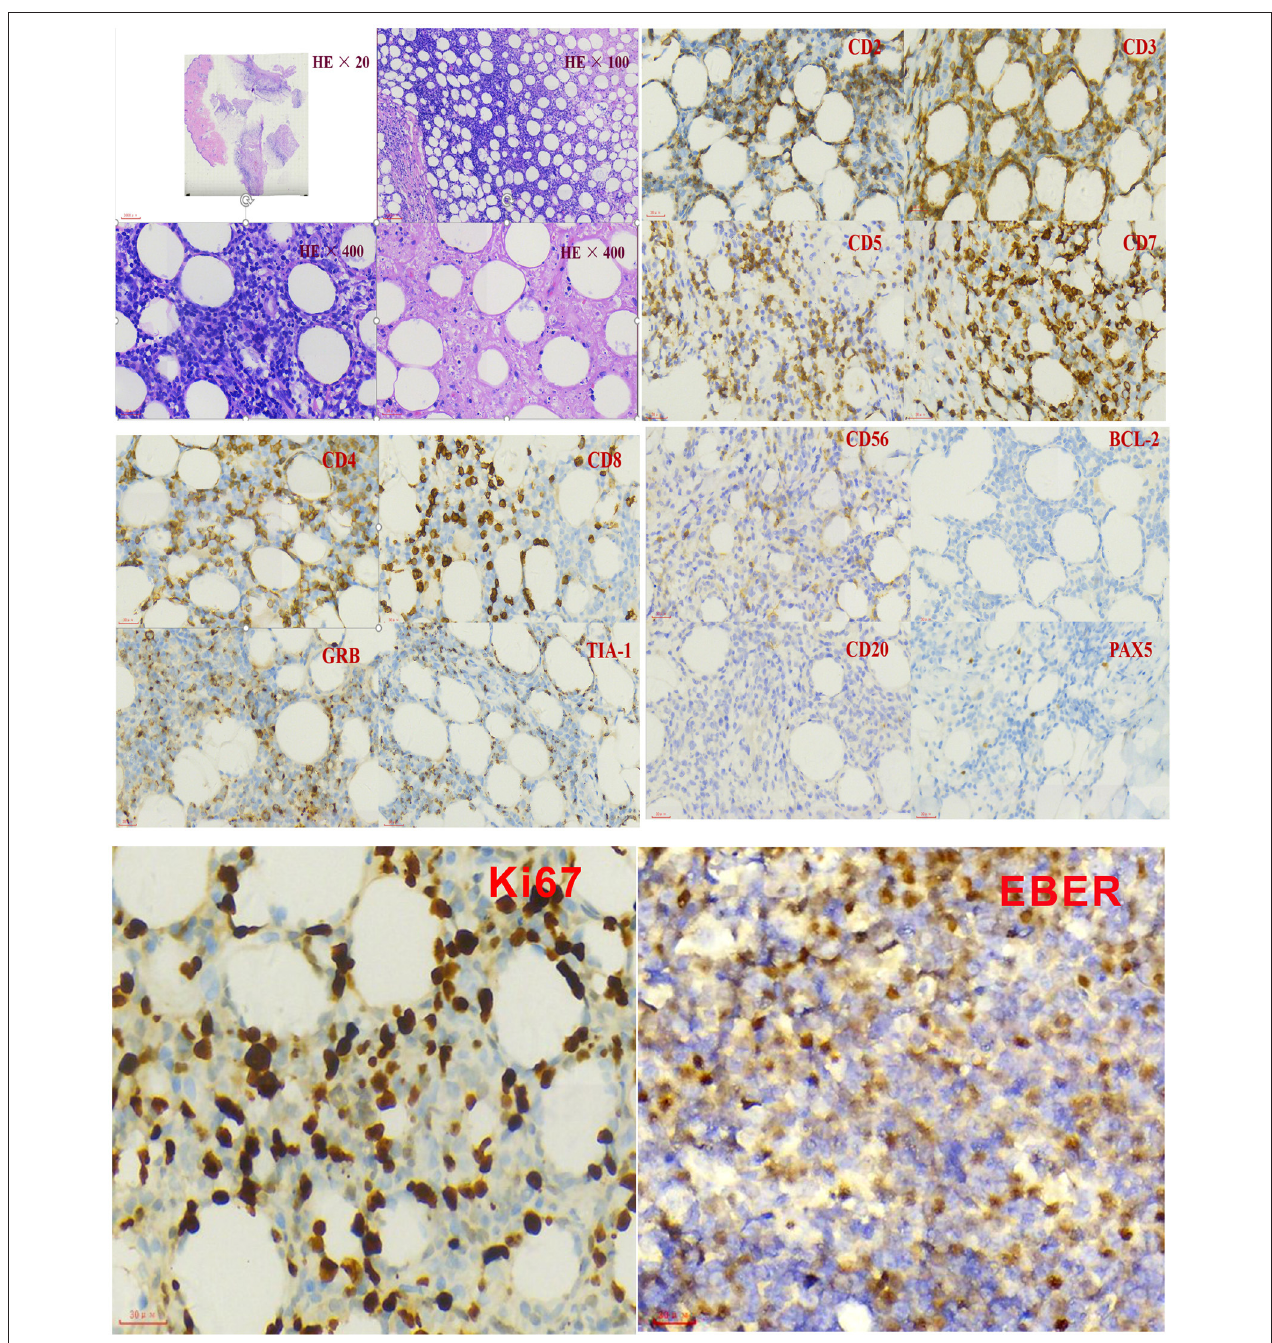
FIGURE 2 | Immunohistochemistry and in situ hybridization with Epstein–Barr virus-encoded small NA (EBER) probe in the skin